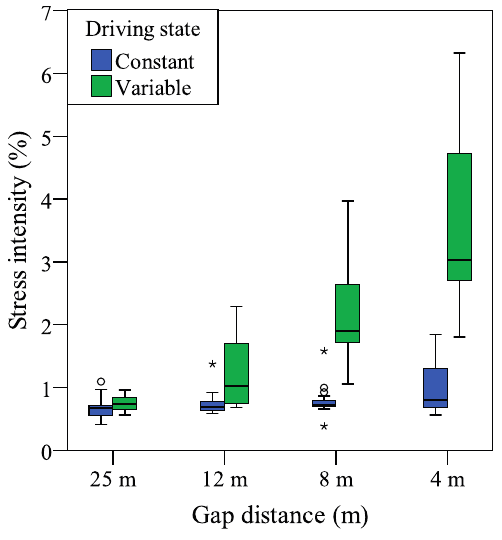
Figure 9. Stress intensity estimated from masseter EMG signal. Depending on the interquartile range for the box plot, outliers are indicated by circles (1.5–3) or stars